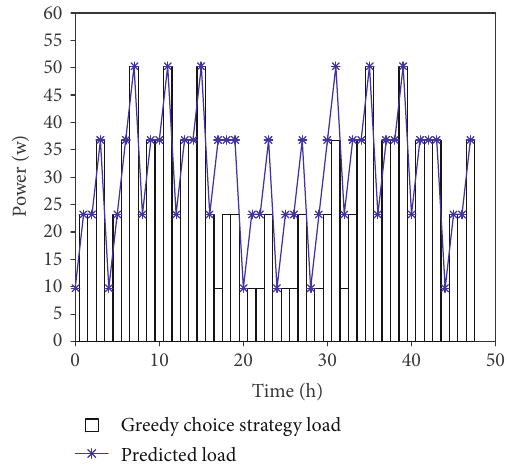
Figure 10: Output power of sleep strategy and predicted load (maximize energy usage with greedy selection strategies —— based on sleep mode switching).